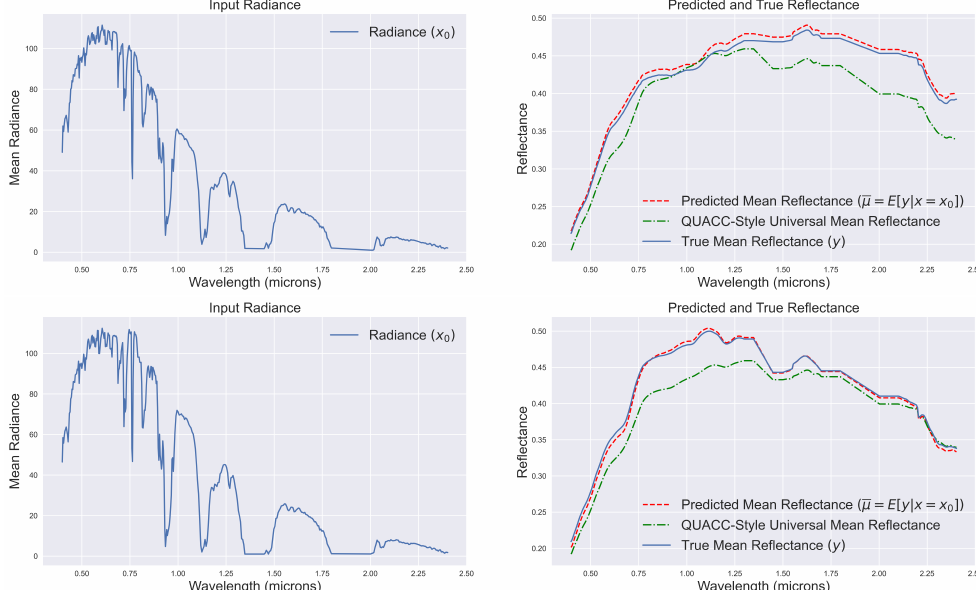
Figure 6. ( left ) Two different mean radiance spectra for different endmember groups and different atmospheres. ( right ) The true mean reflectance for each endmember set, the GPAC predicted mean reflectance, and the QUAC-style universal mean. Observed that the GPAC predicted mean appears to be a better approximation to the actual